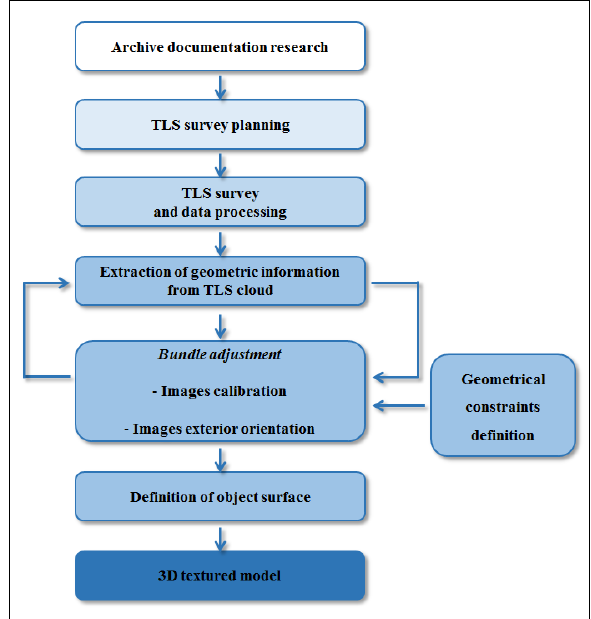
Figure 3. Workflow of the 3D virtual reconstruction. Based on quality and resolution, a set of images were selected, that allowed the photogrammetric reconstruction of all four sides of the tower.